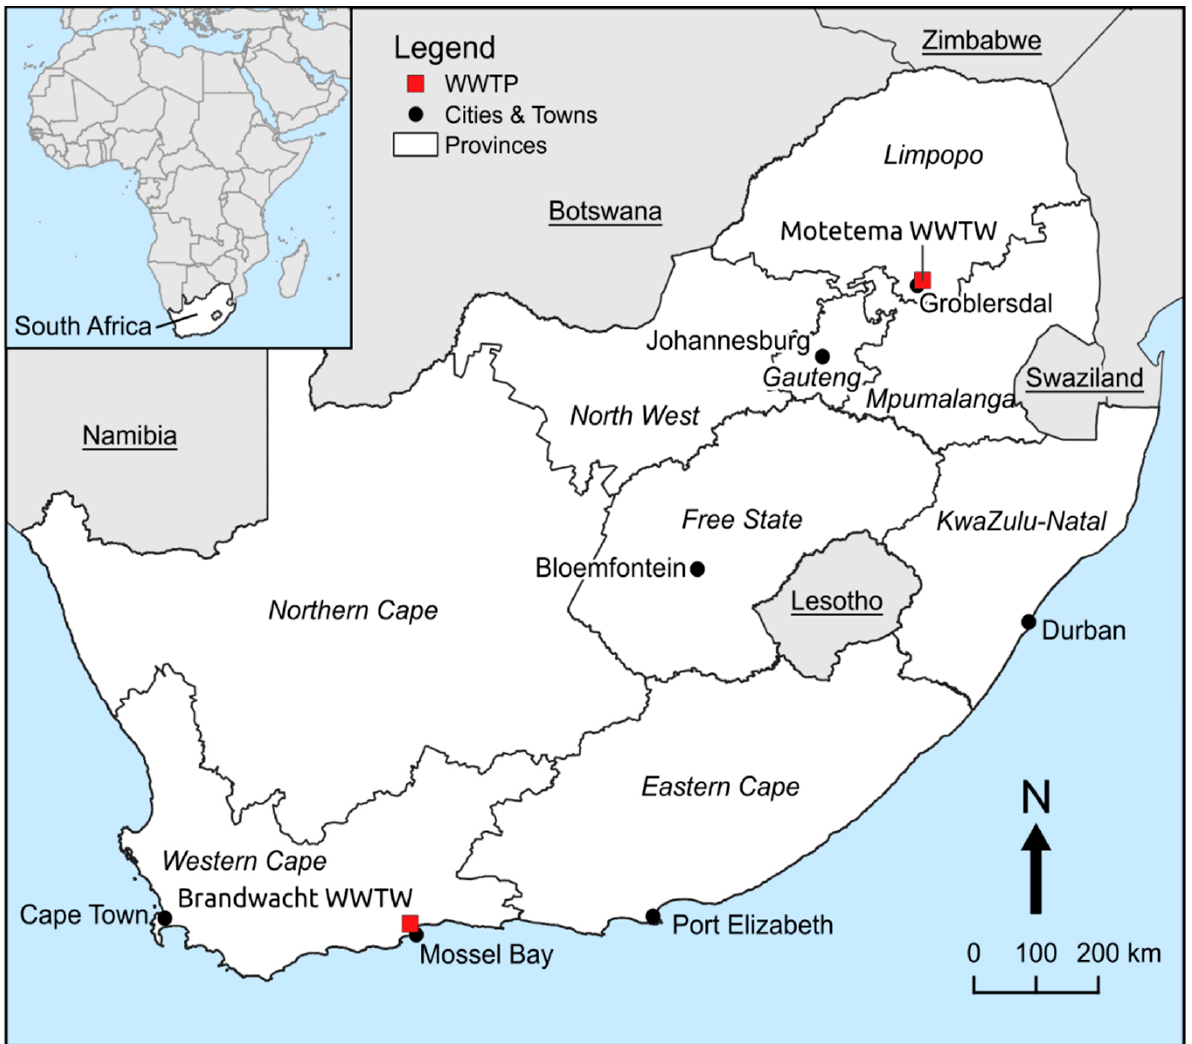
Figure 1. The locations of the Motetema and Brandwag wastewater treatment pond (WWTP) systems in South Africa.